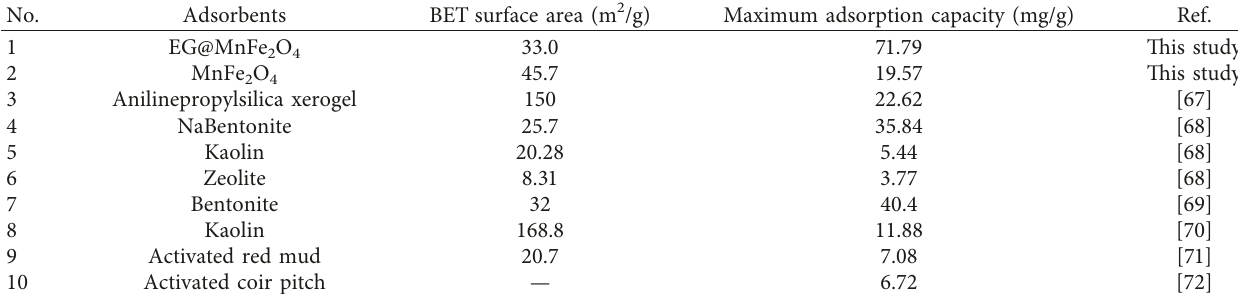
Table 4: Compared BET surface area and maximum adsorption capacity of various